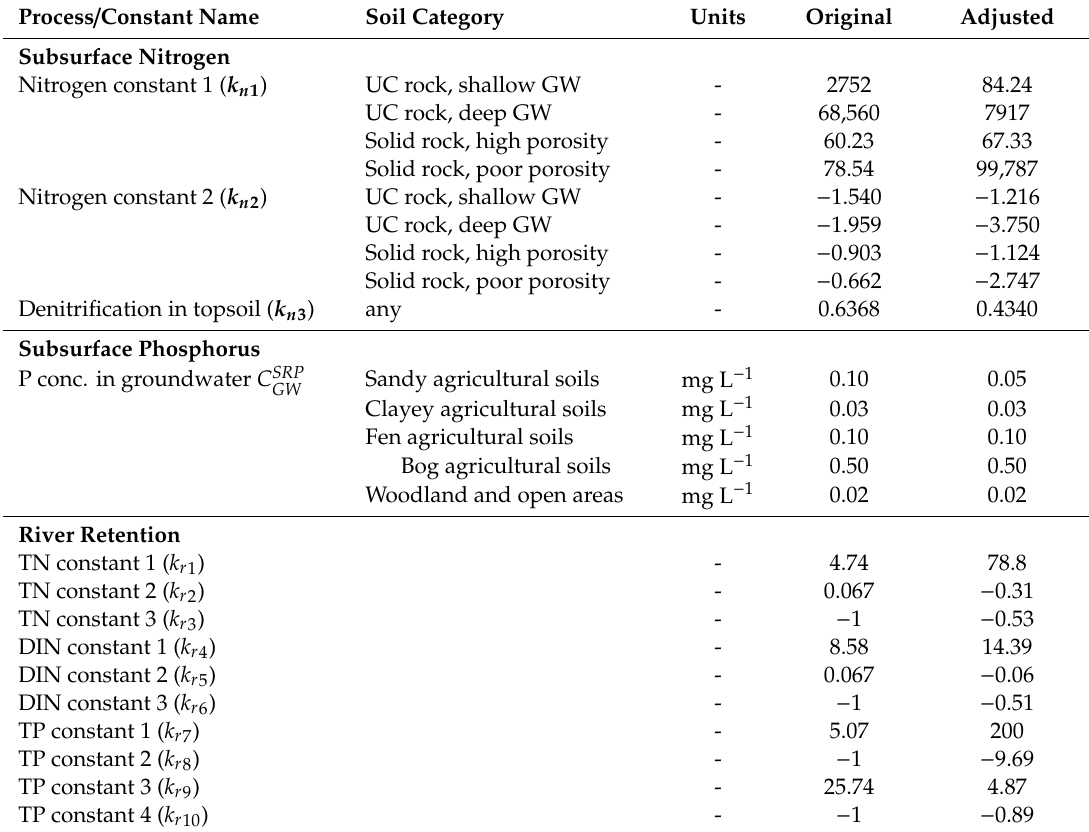
Table 5. Model constants before and after adjustment. The letters in the brackets correspond to those of chapter 2.1. Original: according to [21]; Adjusted: as considered in the present study. UC = unconsolidated; GW = groundwater.